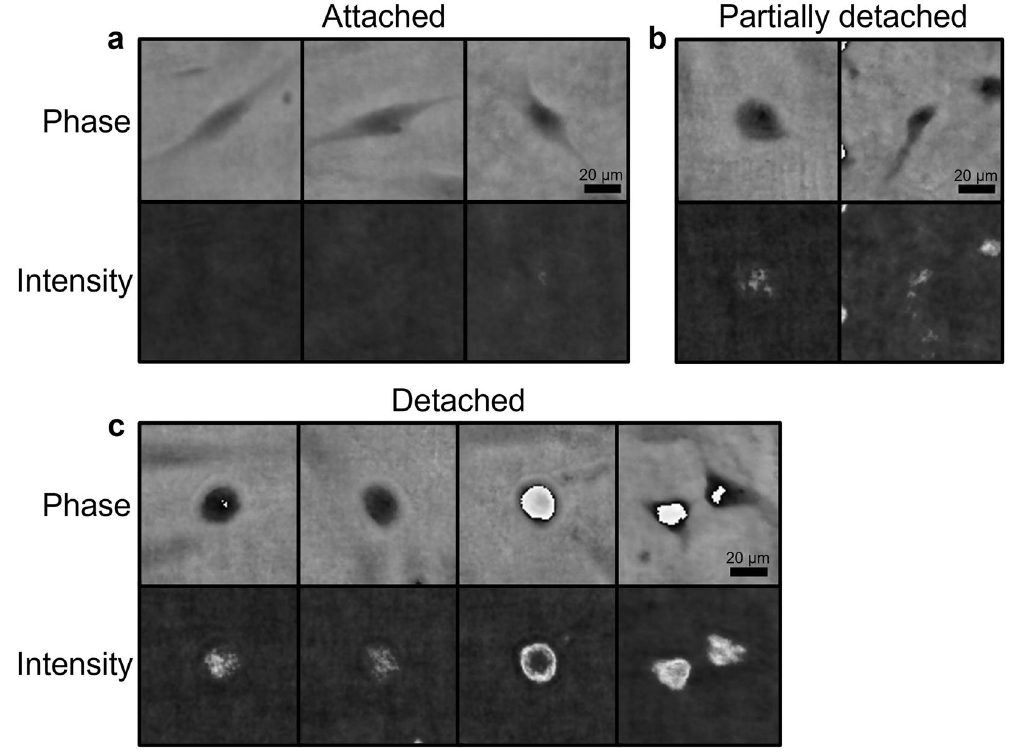
Figure 3. Visualisation of the novel cell detachment feature. Raw phase and intensity images of ( a ) attached, ( b ) partially detached and ( c ) detached